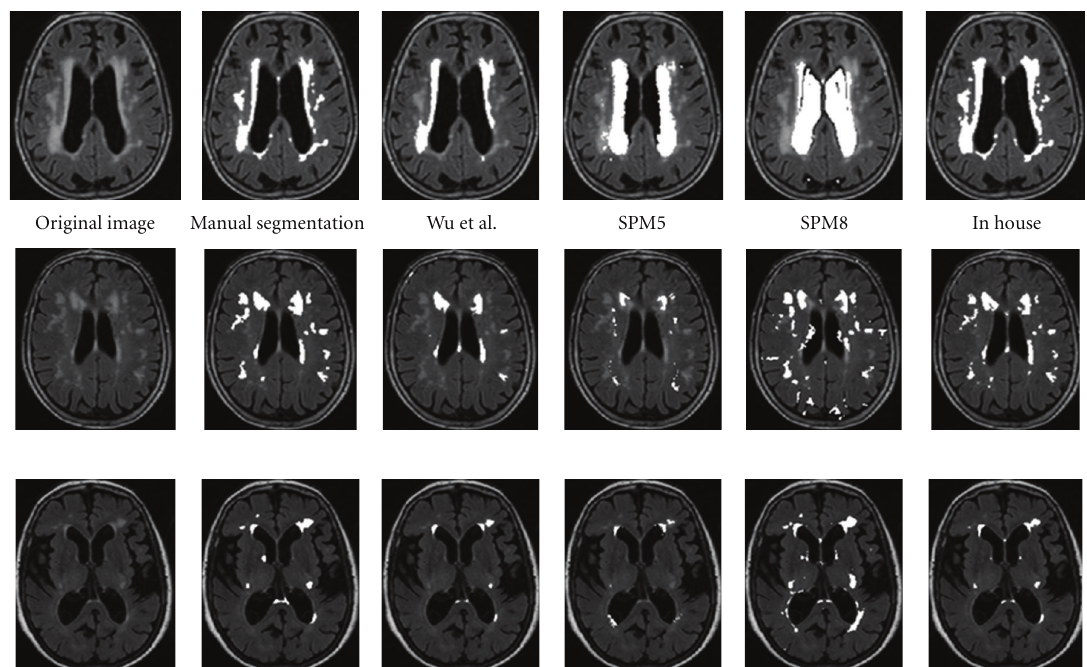
Figure 2: Segmentation results. From left: raw image, manual segmentation, segmentation with Wu et al. software, SPM5 segmentation with WMHs a priori probability included, SPM8 multimodal segmentation with WMHs a priori probability included, and segmentation with in-house